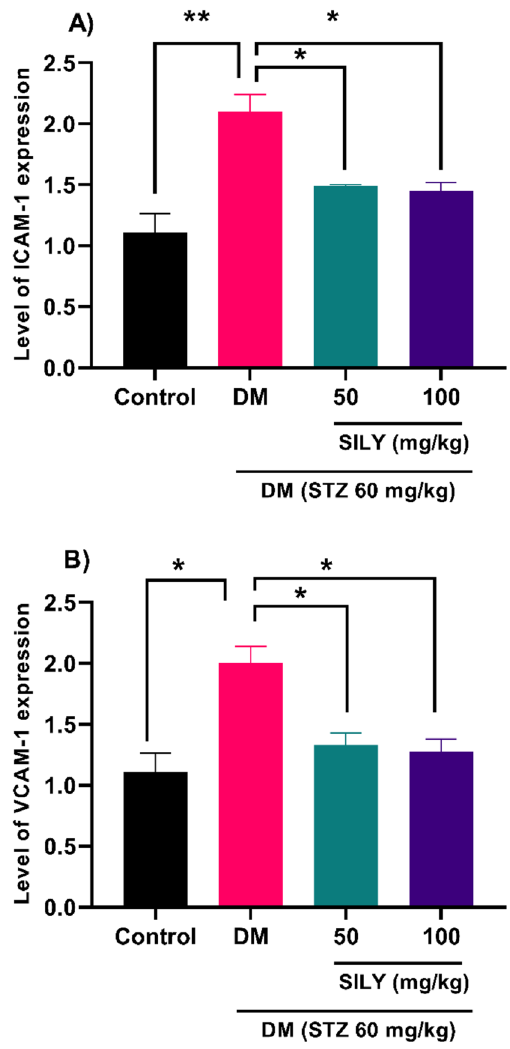
Figure 8. Silymarin attenuates ( A ) ICAM-1 and ( B ) VCAM-1 level in the retina of diabetic rats. Q-RT-PCR was applied to quantify mRNA levels. Data are reported as mean ± SD. The differences between groups were compared using one-way ANOVA and Tukey’s post hoc test. Eight animals in each group were utilized for this experiment. * and ** showing P < 0.05 and p < 0.01, respectively. DM: diabetes mellitus; SILY: silymarin, ICAM-1: Intercellular Adhesion Molecule 1, VCAM-1: vascular cell adhesion molecule